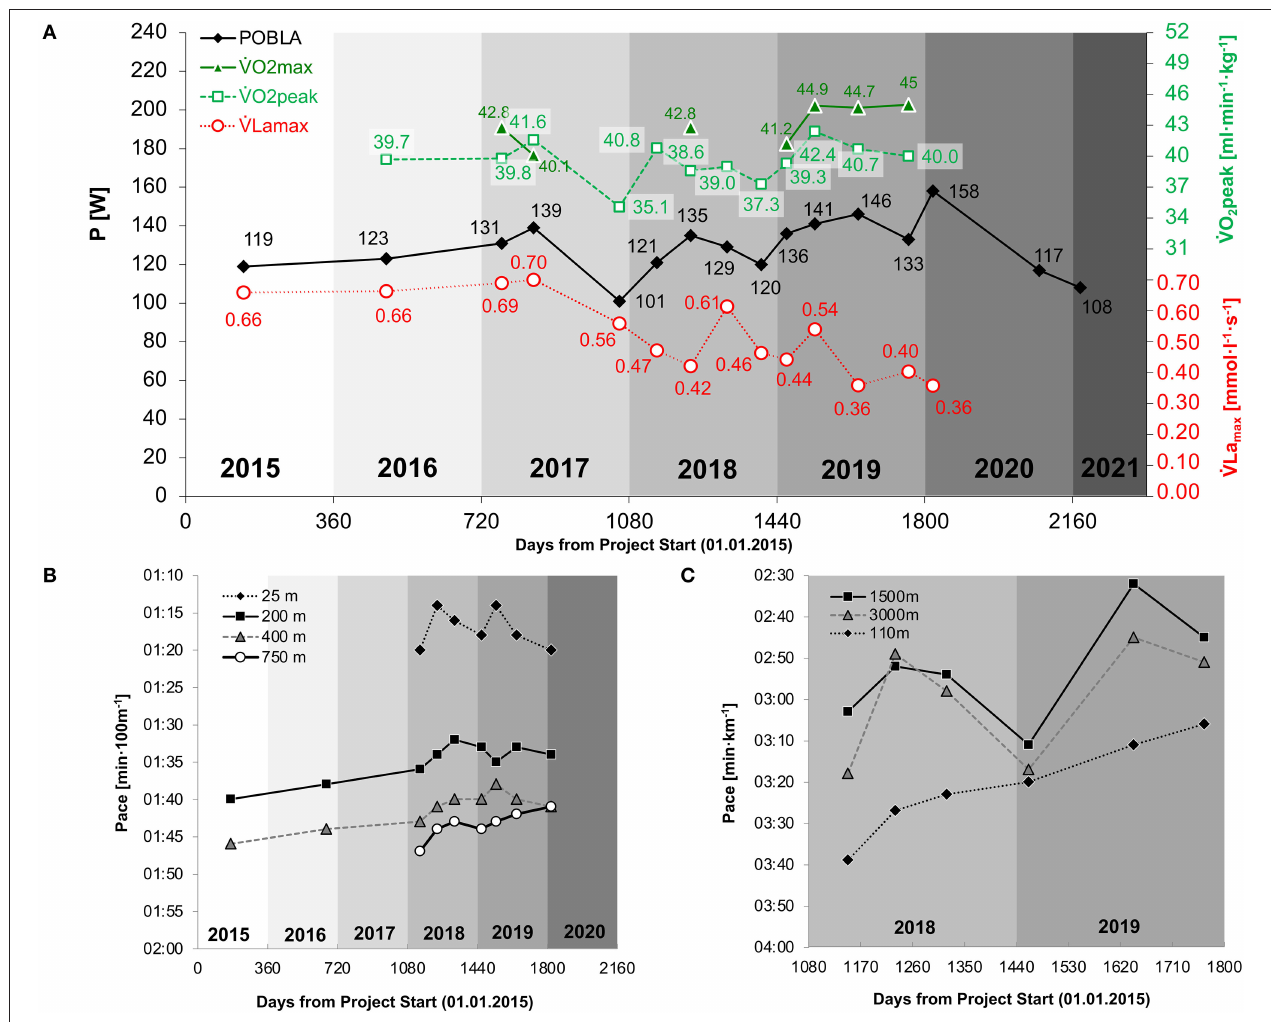
FIGURE 2 | Performance development in handcycling (A) , swimming (B) , and wheelchair racing (C) ˙VL a max , maximal lactate accumulation rate (mmol · l − 1 · s − 1 );